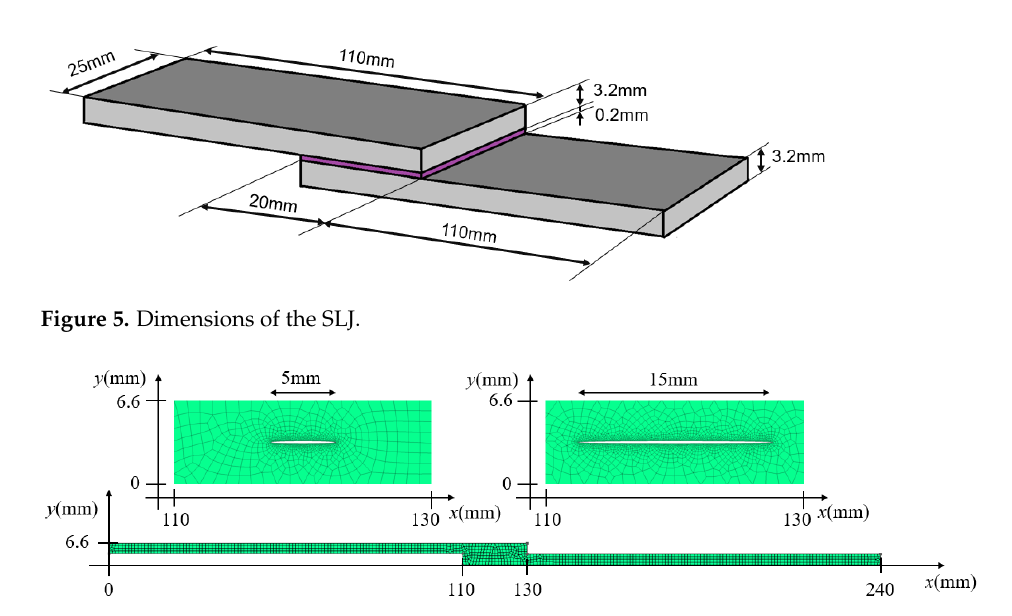
Figure 6. Designed mesh for the SLJ with the respective zooms around the defect.